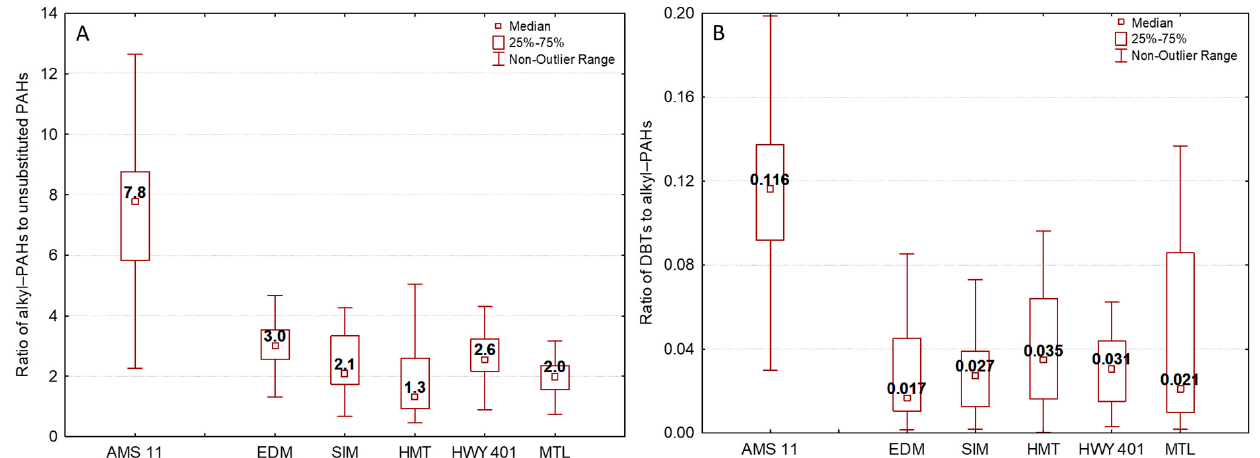
Figure 3. Ratios of ( A ) alkyl-PAHs/PAHs and ( B ) DBTs/alkyl-PAHs at the five NAPS sites and the industrial-petrogenic AMS11 site for comparison [16].